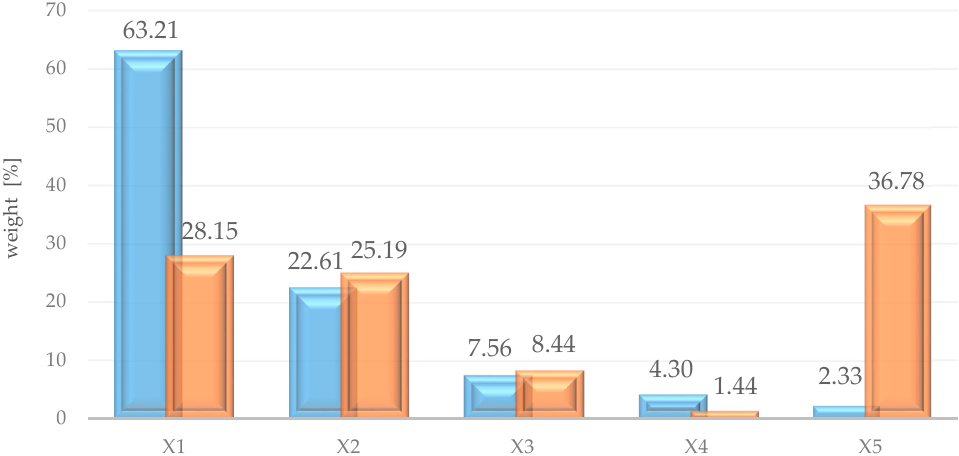
Figure 7. Comparison of the weights of attributes for plots in “ex ante” and “ex post” conditions.